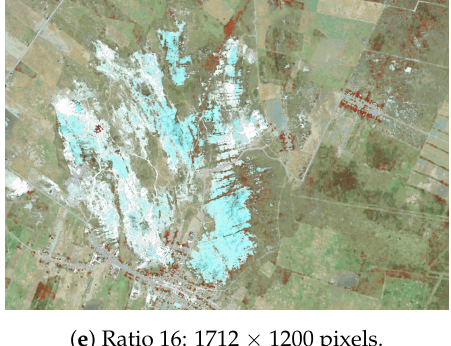
Figure 13. Generated images with different resolutions given the RGB input in a trained network with 30 m resolution